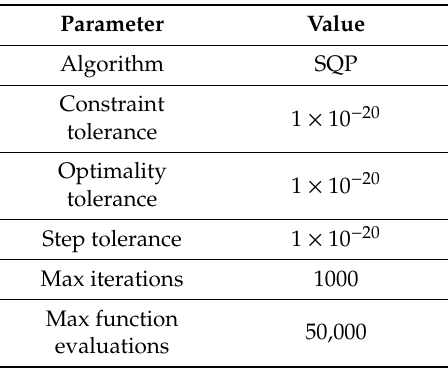
Table 6. The parameters of the fmincon function in